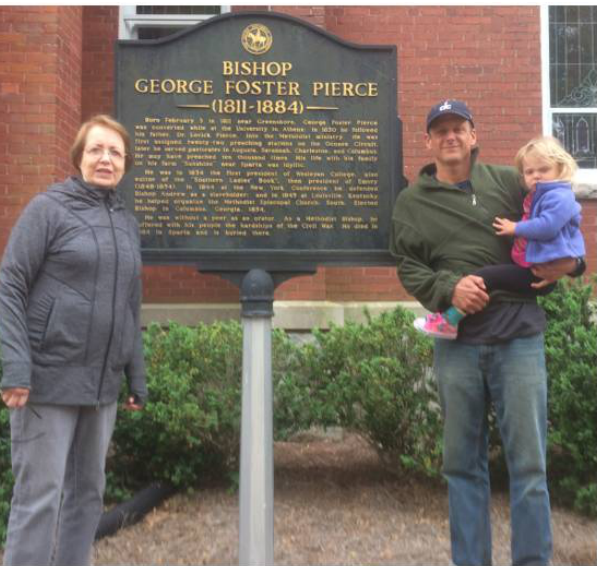
Figure 2. My mother, Nancy Braselton Gorman, and author, Leo Braselton Gorman, with daughter, Nitza Thanos Gorman, at Pierce Memorial United Methodist Church in Greensboro, Greene County, Georgia in 2018. Photograph courtesy of Jasper Thanos Gorman.